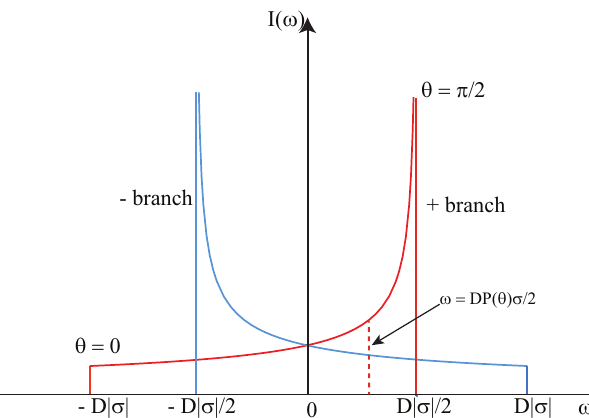
Figure 5. Calculated Pake doublet line shape for the long-range ordered Pa3 structure of solid H 2 for a fixed value of the order parameter σ and a distribution of angles α for the the axes of a powdered sample.